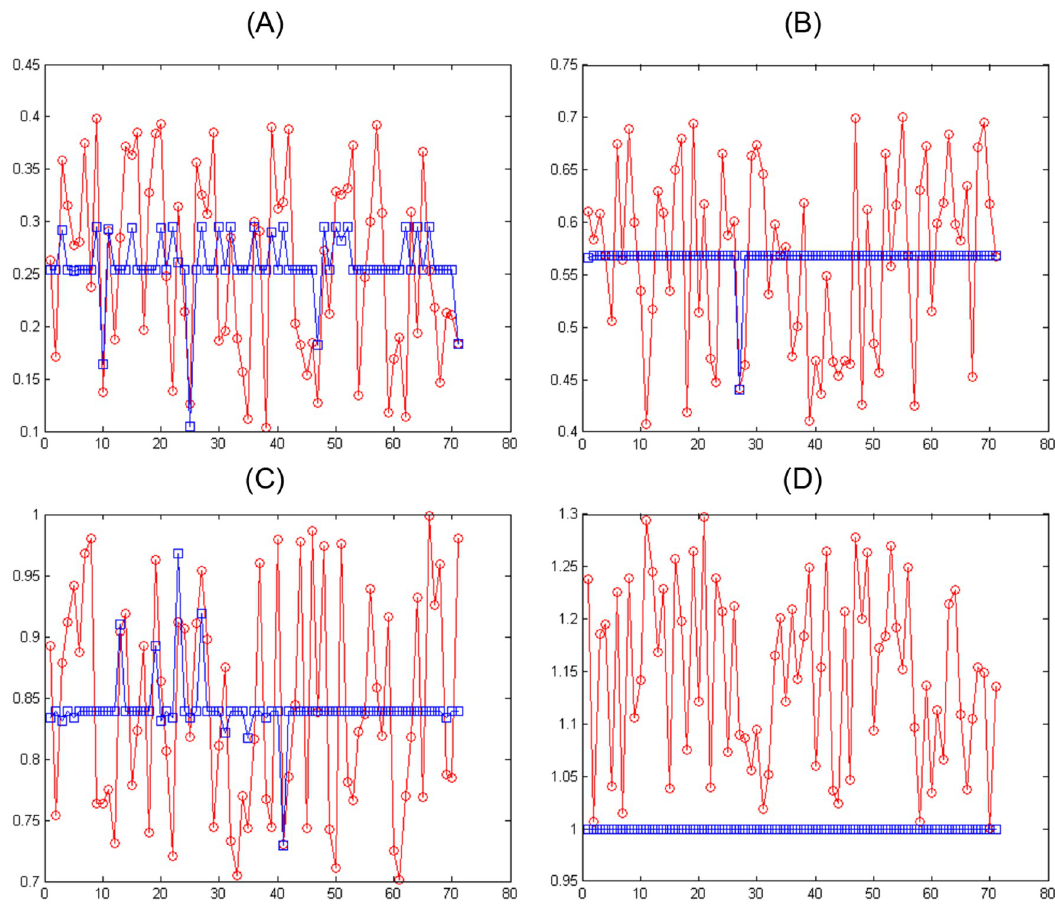
Fig 4. The distance of the obtained answer (blue chart) in each generation change compared to the real answer (red chart) in training samples with ANN-PSO: (Fig 4A)[0.1, 0.4], (Fig 4B)[0.4, 0.7], (Fig 4C)[0.7, 1] and (Fig 4D)[1, 1.3] range.